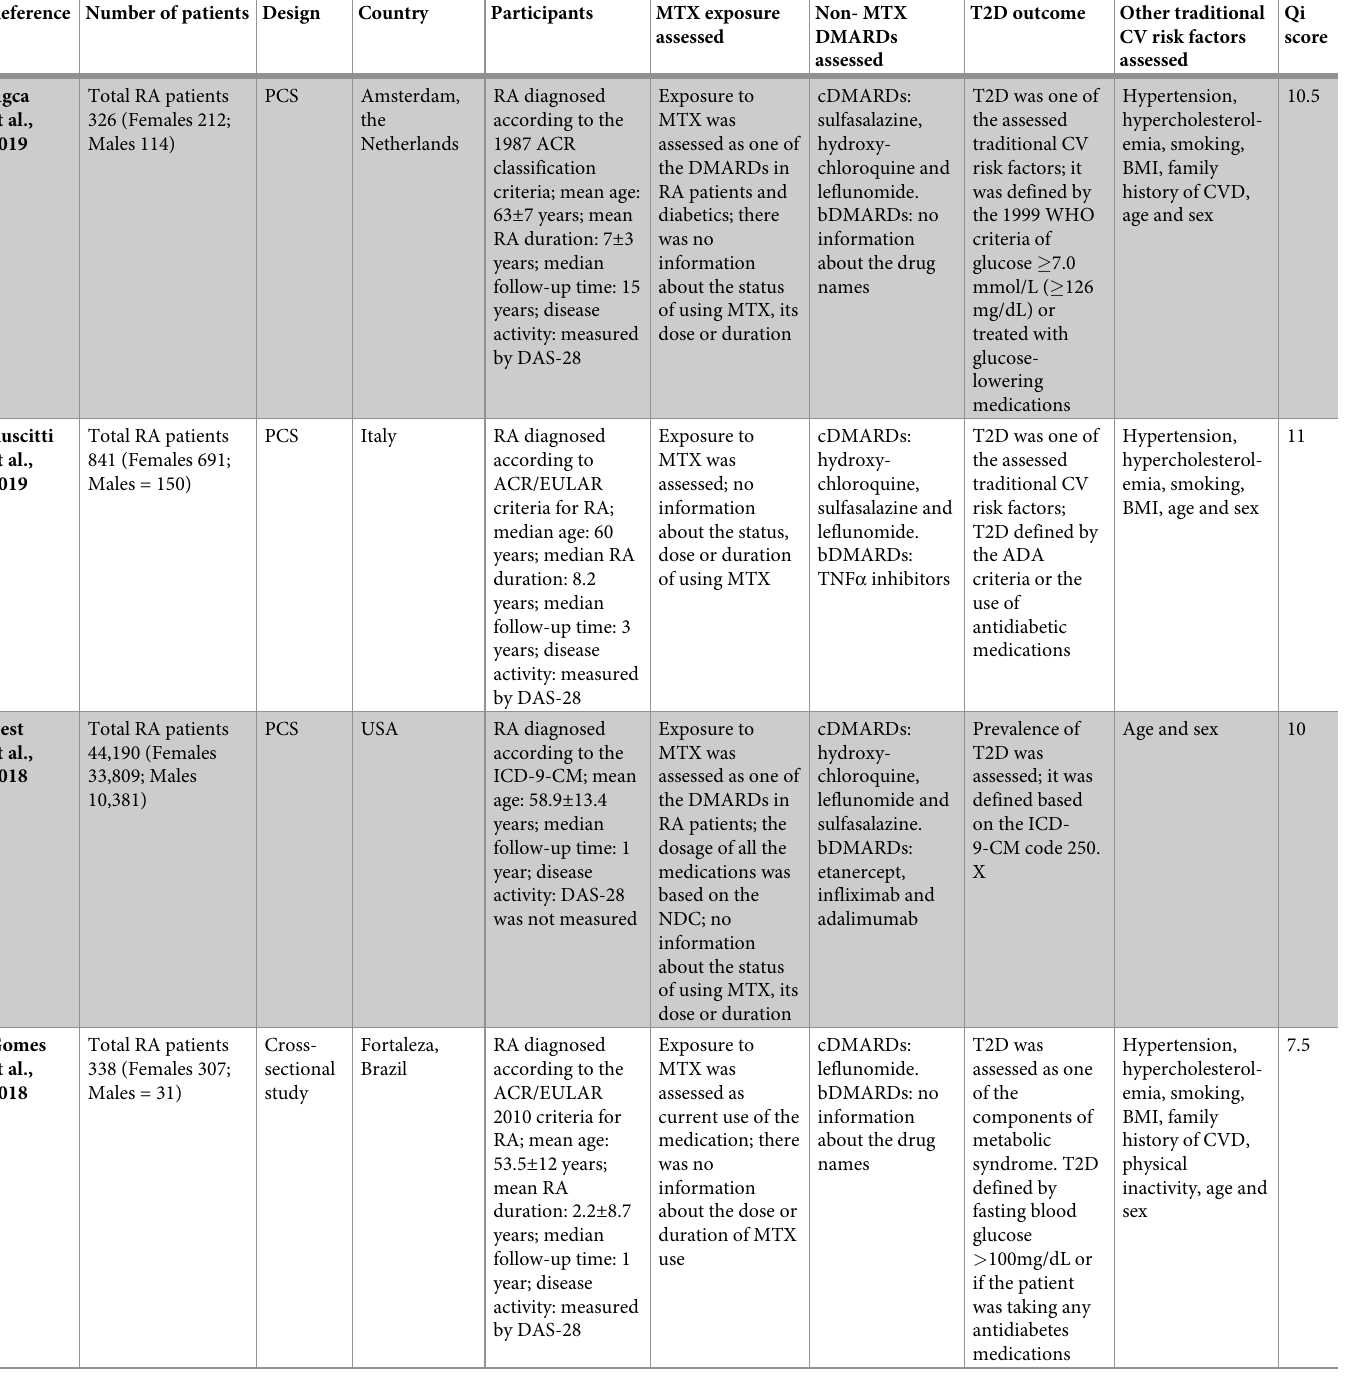
Table 1. Overview of all included studies (n = 16), sorted by publication date in descending order. Reference Number of patients